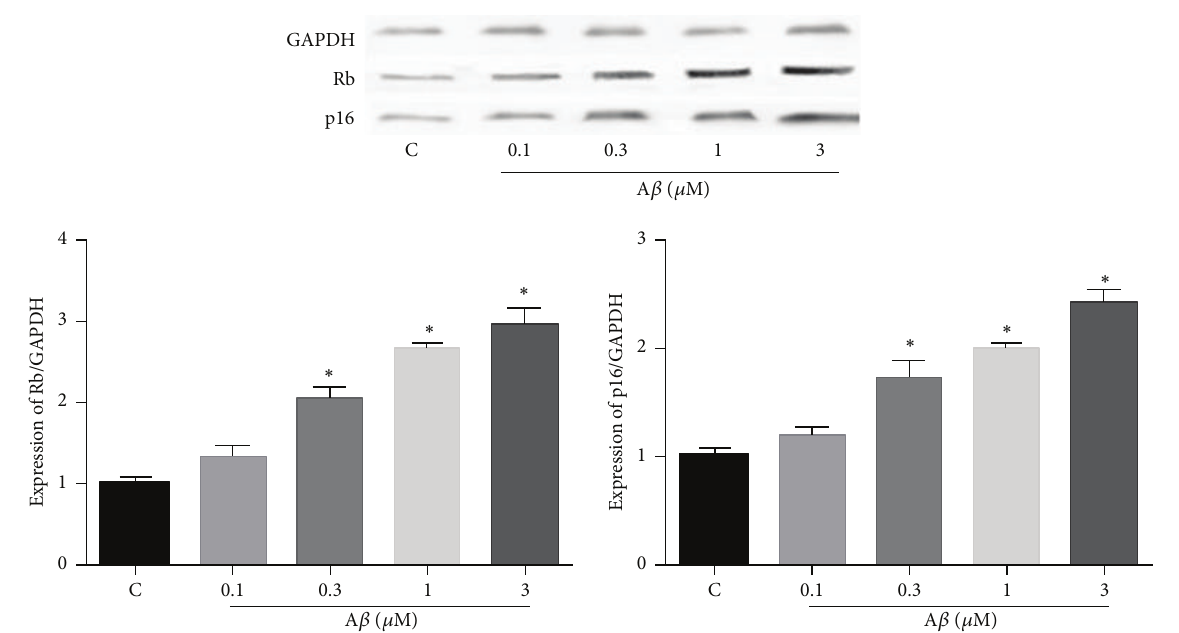
Figure 9: The influence of A 𝛽 1 on the expression of Rb1 and p16 in NSPCs. The NSPCs were treated with (1) none, (2) 0.1 𝜇 M A 𝛽 1 – 42 , (4) 1 𝜇 M A 𝛽 1 , and (5) 3 𝜇 M A 𝛽 1 . The expression of Rb1 and p16 was detected by WB. ∗ 𝑃 < 0.05 versus control group. 0.3 𝜇 M A 𝛽 1 – 42 – 42 – 42